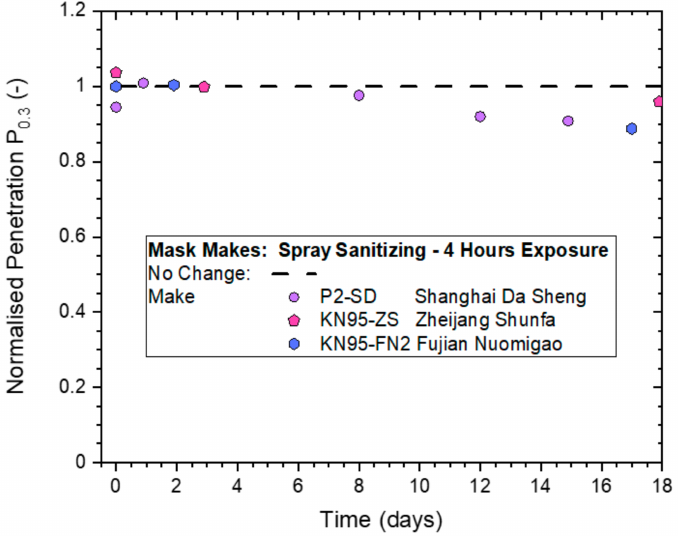
Figure 12. Normalized penetration P n0.3 from whole-mask screening testing of three different makes of disposable masks exposed to continuous spray sanitizing actions for 4 h.